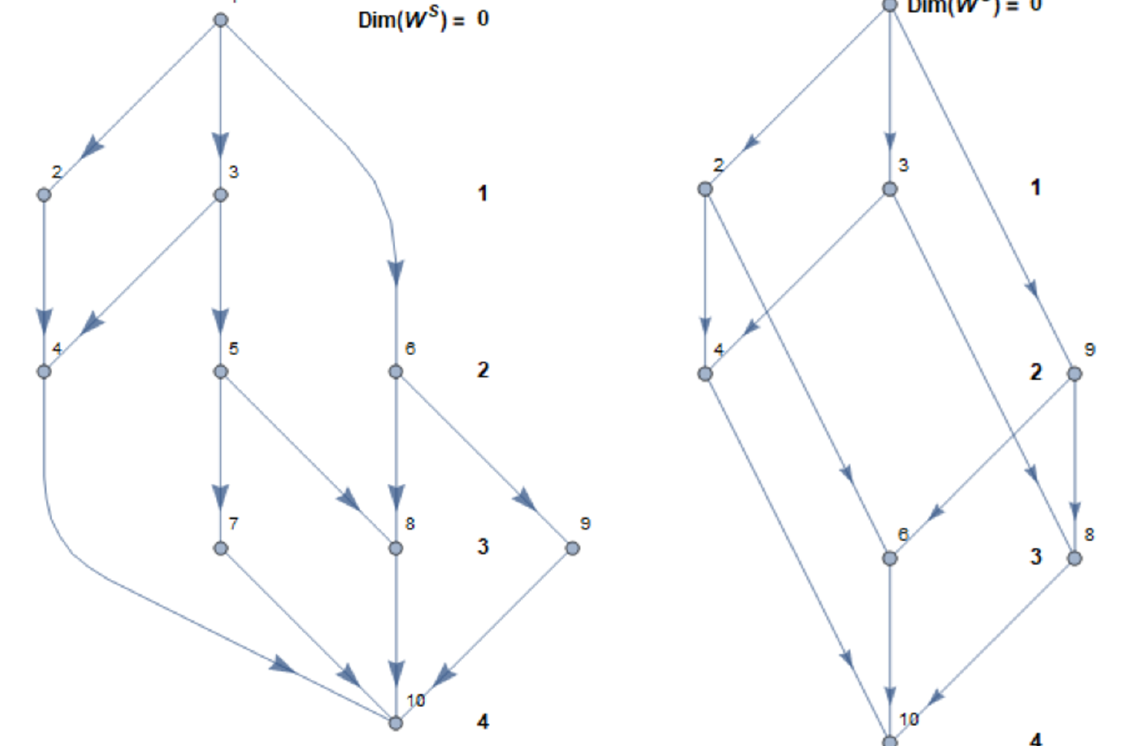
Figure 6. Stability of the (cid:12)xed points and topology of the RG-(cid:13)ow between the (cid:12)xed points on the four dimensional invariant set (cid:11) g = 0 at ( N c ; N f ) = (3 ; 15) (left), and at ( N c ; N f ) = (3 ; 3) (right). Bold numbers correspond to the dimension of the stable manifold at the (cid:12)xed